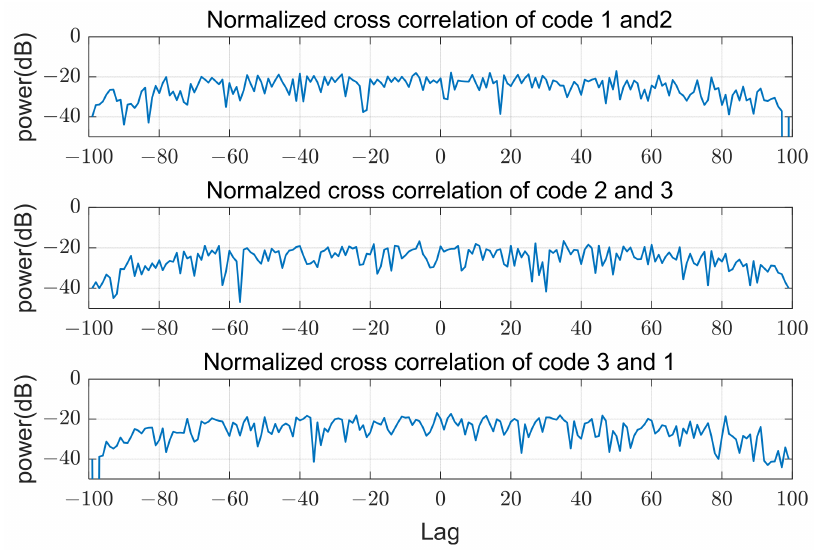
Figure 7. Normalized cross-correlation of